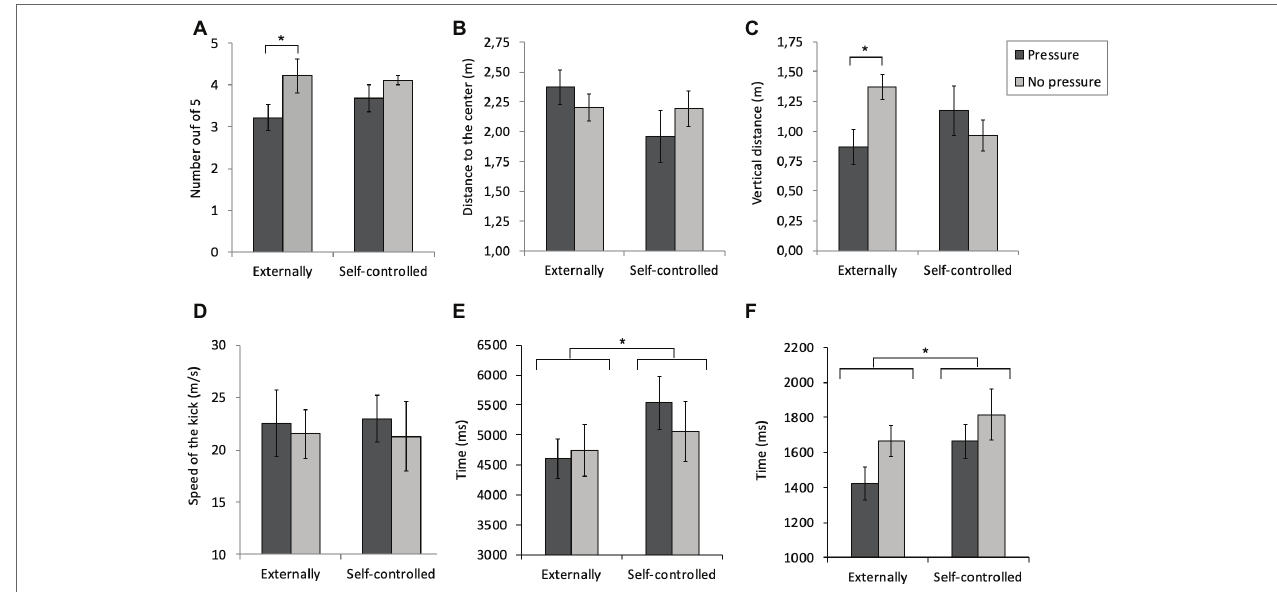
FIGURE 3 | Performance measures of the kicks (A–D) and penalty takers behavior (E,F) . Error bars represent standard error of the mean. * p <